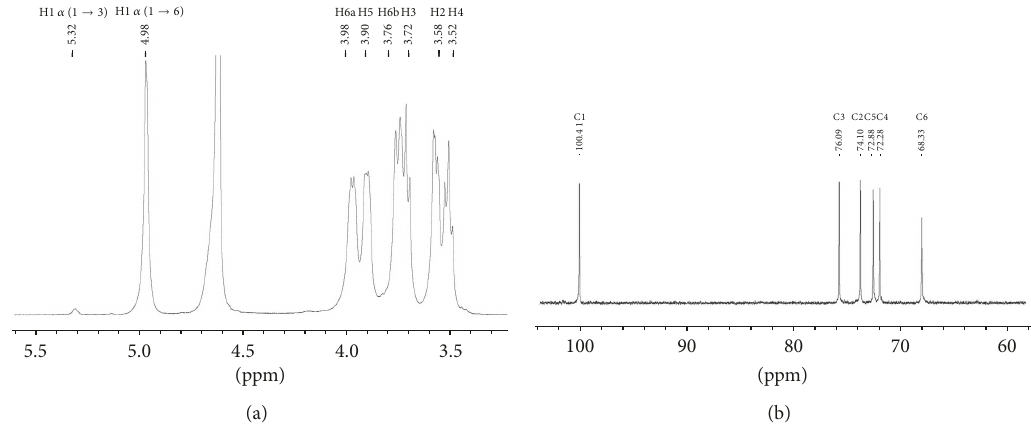
Figure 3: 1D NMR spectrum of purified dextran from W. confusa R003 recorded at 40 ∘ C in D 2 O: (a) 1 H NMR (500 MHz); (b) 13 C NMR (125MHz).